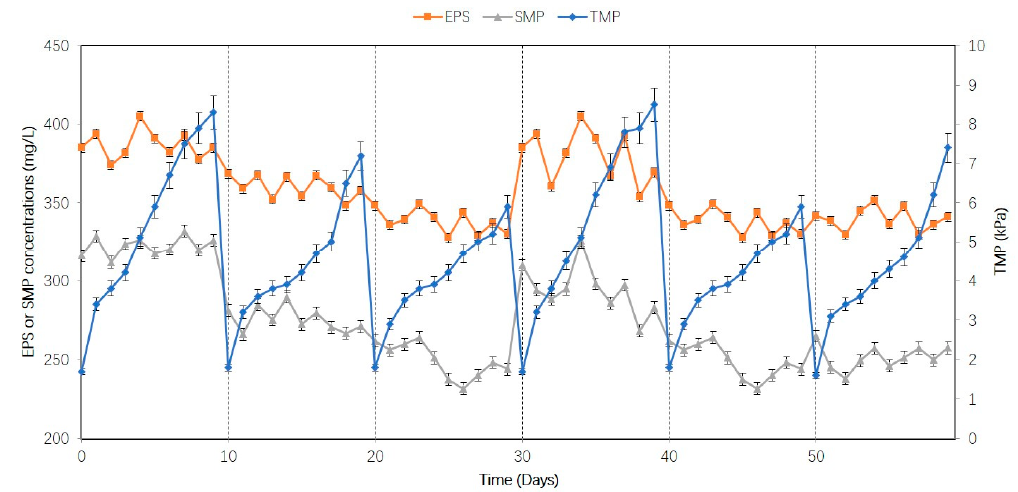
Figure 3. Trans-membrane pressure (TMP), extracellular polymeric substances (EPS), and soluble microbial products (SMP) changes during the study.